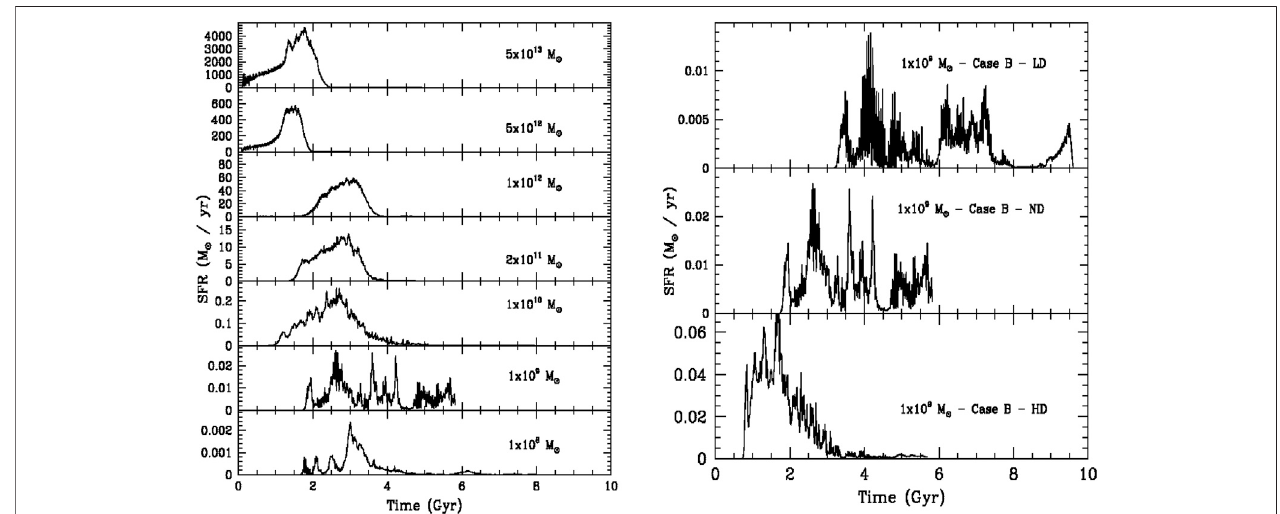
FIGURE 6 | Left panel: The SFR as a function of time for the model galaxies of type B of Chiosi and Carraro (2002). Their initial conditions are rather simple and grouped according to the initial over-density: models of type A had mean initial density 〈 ρ 〉 ≃ 200 × ρ u ( z ), whereas models of type B had 〈 ρ 〉 ≃ 5 × ρ u ( z ) where ρ u ( z ) is the density of the Universe at redshift z . The Hubble constant was H 0 (cid:1) 65 km s − 1 Mpc − 1 and the redshift of the starting collapse z f (cid:1) 5. Only models B are shown here because they are particularly useful to highlight the effect of the mass at given initial over-density. From the bottom to the top, the SFRs refer to galaxies with M T (cid:1) M DM + M BM from1 × 10 8 M ⊙ to5 × 10 13 M ⊙ .Theinitialbaryonicanddarkmassare M BM (cid:1) 0.1 M h and M DM (cid:1) 0.9 M h ,respectively. Rightpanel: theSFRoflowmasstype B galaxies of the same mass, but different initial over-density. The mass is M T (cid:1) 10 9 M ⊙ . The initial over-density varies from low (LD) to intermediate (ID) to high values (HD). The fi gures are reproduced from Chiosi and Carraro